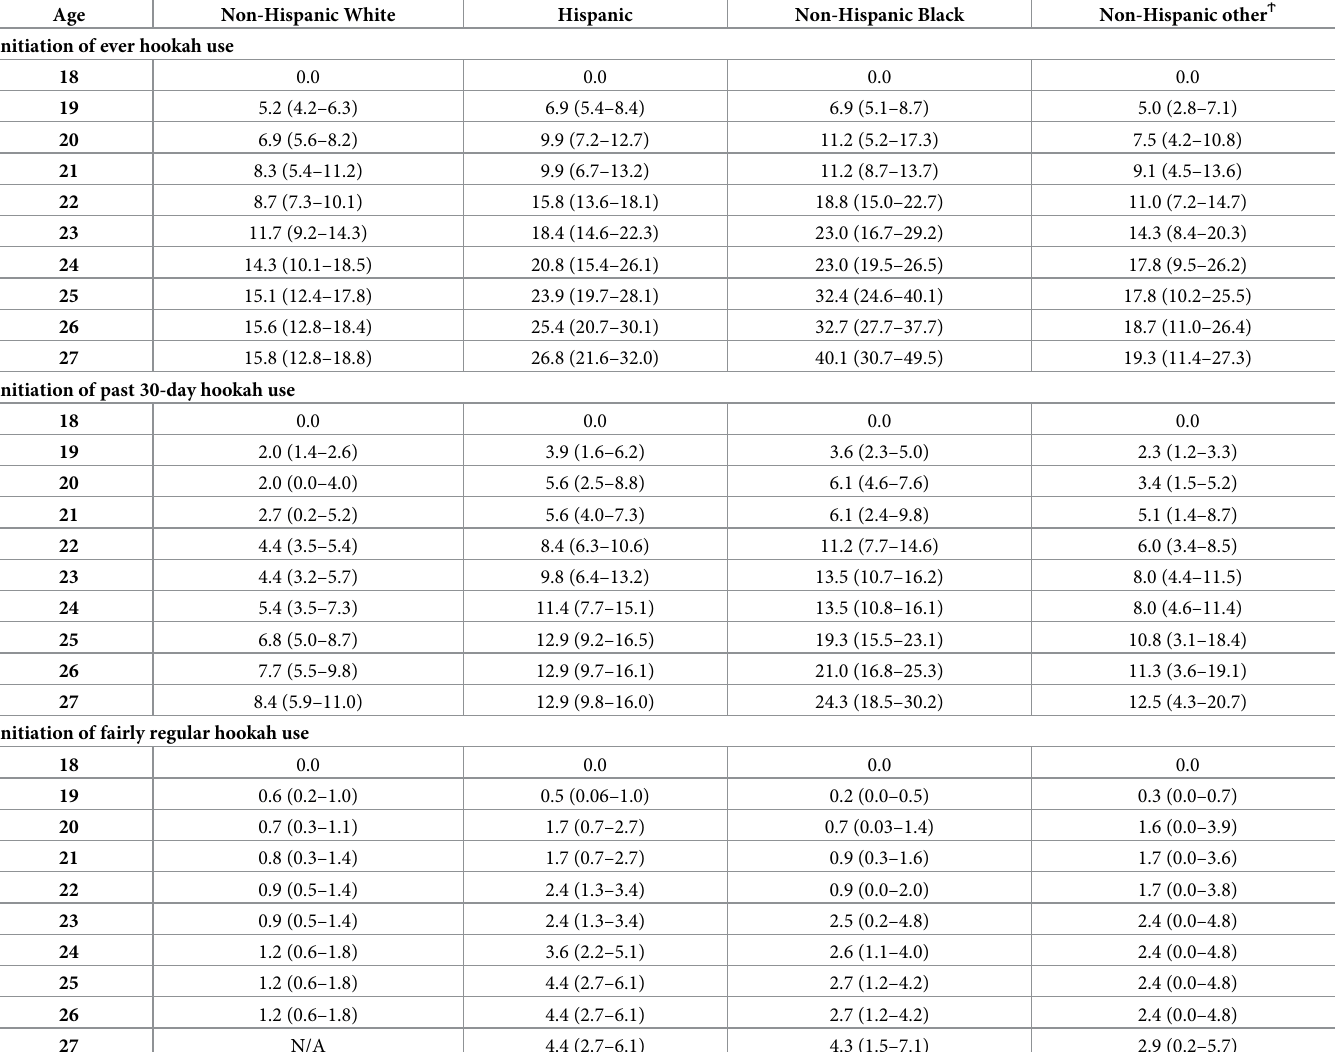
Table 5. Estimated hazard functions a (and 95% confidence intervals b ) for the age of hookah initiation behaviors for the PATH¥ young adults (aged 18–24) by race/ ethnicity Ϯ